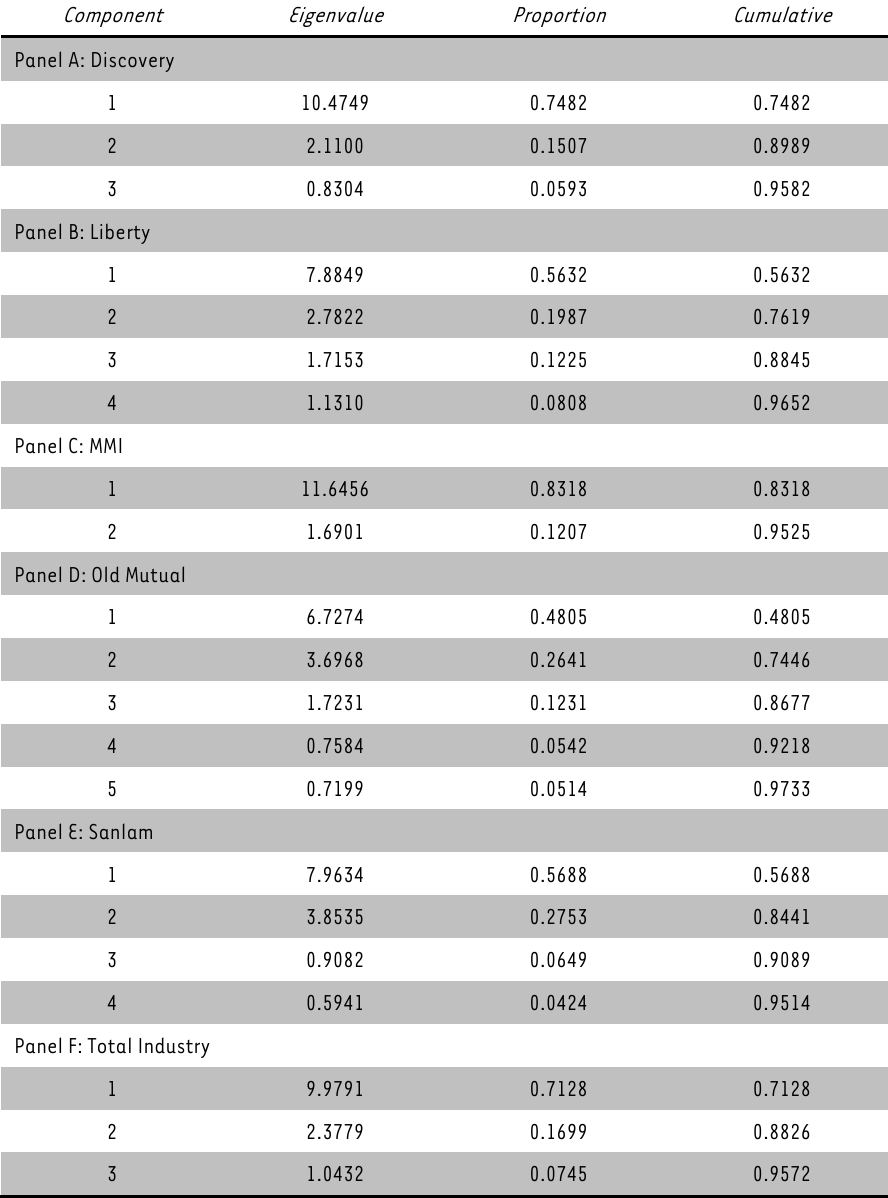
TABLE 4: Eigenvalues for Insurance